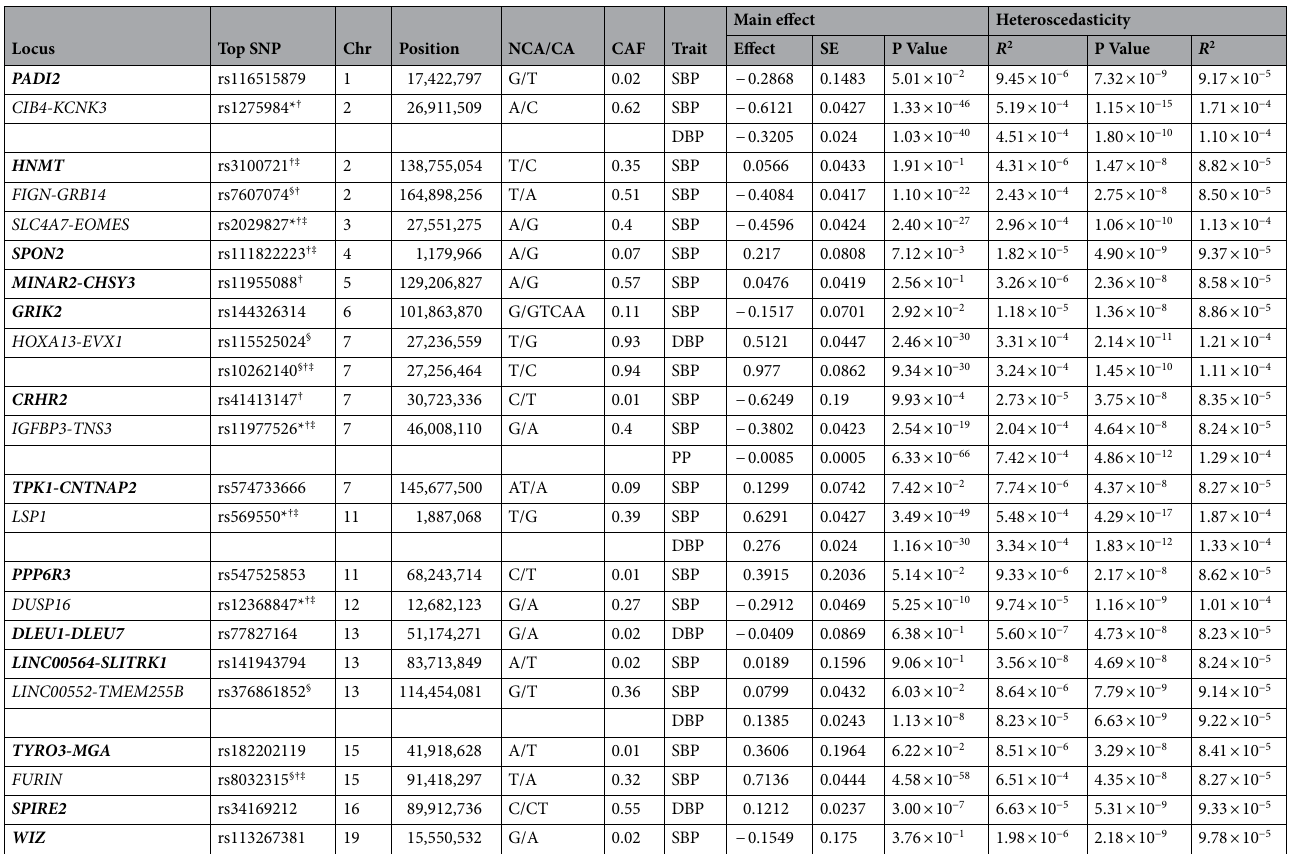
Table 1. Genome-wide significant vQTLs associated with SBP, DBP, or PP. Novel loci are highlighted in bold. Positions are given in GRCh37 coordinates. SNP effects are in mm Hg per copy of the coded allele. *The SNP is, or in linkage disequilibrium (LD R 2 ≥ 0.8) with, a BP-associated SNP in the GWAS catalog. † The SNP is